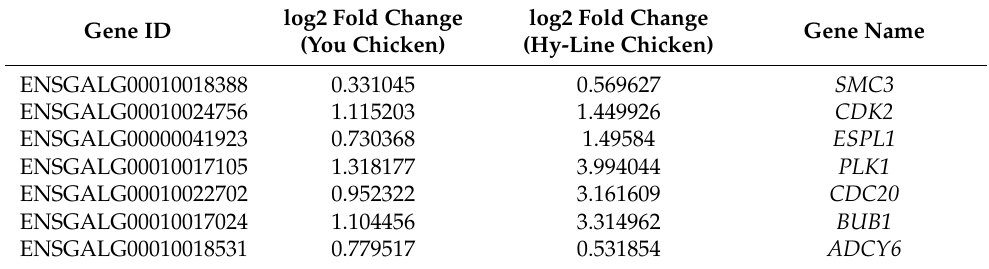
Table 2. Genes regulating “oocyte